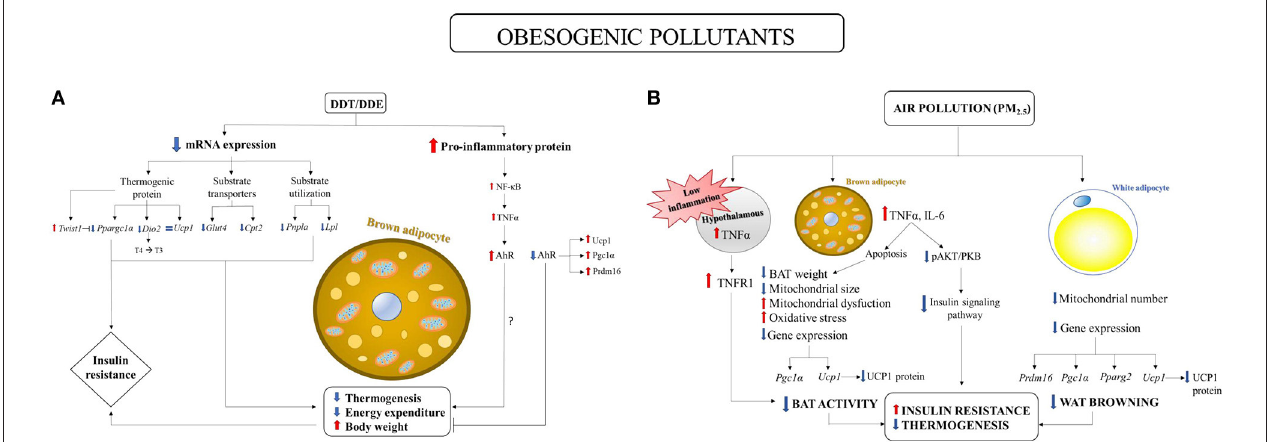
FIGURE 1 | Environmental pollutant-induced obesity and metabolic diseases: involvement of BAT impairment. (A) Perinatal exposure to DDT in mice elicited reductions in mRNA expression of: (1) proteins involved in substrates transporters: glucose transporter type 4 ( Glut4 ) and carnitine palmitoyltransferase 2 ( Cpt2 ); (2) proteins involved in substrate utilization: adipose triglyceride lipase ( Pnpla ) and lipoprotein lipase ( Lpl ); (3) proteins involved in thermogenesis: iodothyronine type II deiodinase ( Dio2 , which encodes the enzyme that locally activates thyroid hormones through the deiodination of T4 to T3) and peroxisome proliferative activated receptor gamma coactivator 1 alpha ( Ppargc1a, a master regulator in the thermogenesis), associated with an increase in the expression of twistrelated protein 1 ( Twist1 ), a negative regulator of Ppargc1a . (La Merrill et al., 2014). Ppargc1a reduction may induce insulin resistance (Kleiner et al., 2012). No variation was found